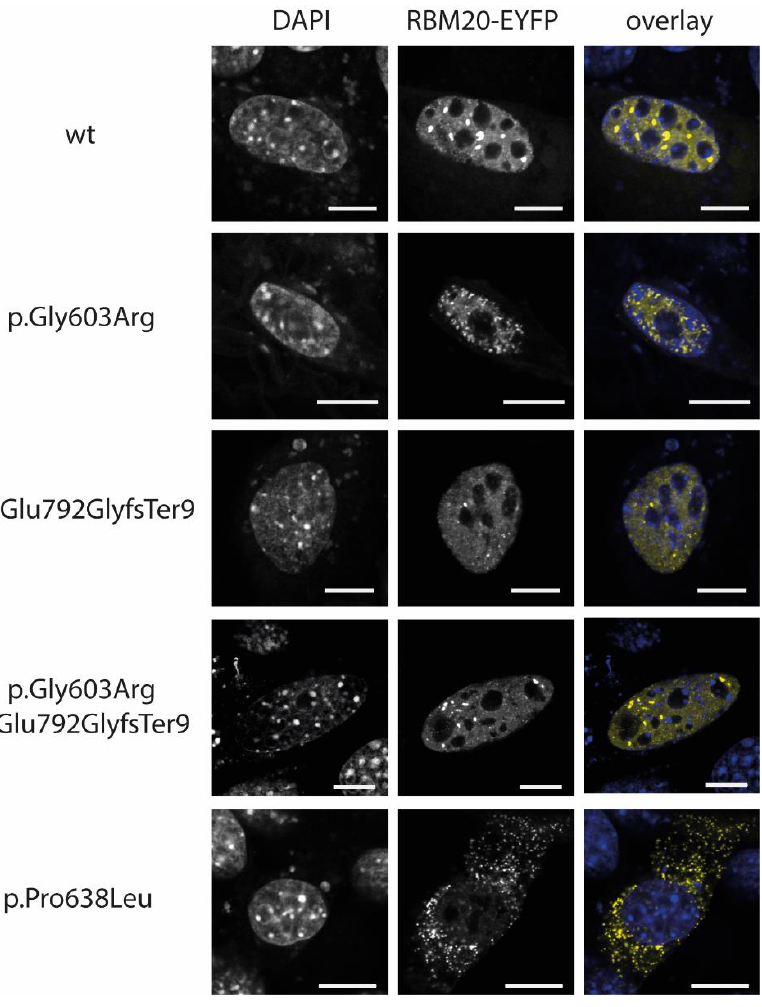
Figure 3. Localization analyses of RNA binding motif protein 20-enhanced yellow fluorescent protein (RBM20-EYFP) transfected C2C12 cells. RBM20 is shown in yellow, and the nuclei were labelled with 4’,6-diamidine-2’-phenylindole dihydrochloride (DAPI, blue) in the overlay. EYFP tagged wildtype RBM20 localizes in the nucleus. The mutant forms of RBM20 (p.Gly603Arg and p.Glu792GlyfsTer9) are comparably localized in the nuclei. As described previously [10] , only the mutant form RBM20-p.Pro638Leu shows an abnormal cytoplasmic localization. Scale bars = 10 µm.